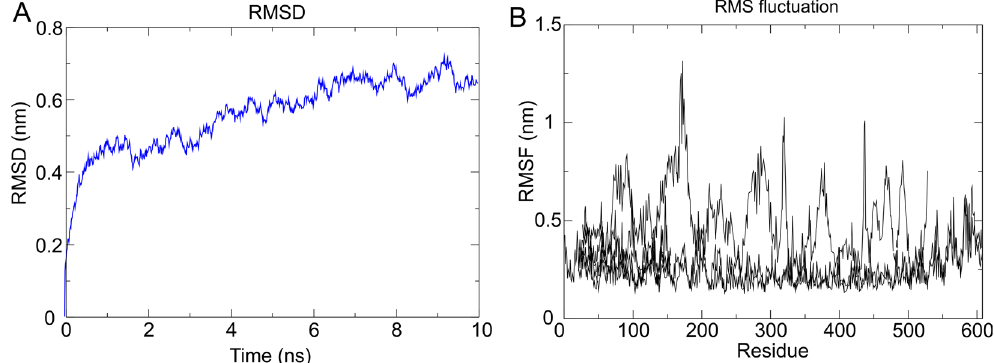
Figure 7. Molecular dynamics simulation study of protein-ligand complex representing. ( A ) Root Mean Square Deviation of the docked complex backbone for the time duration of 10 ns. ( B ) Root Mean Square Fluctuation representation of the docked complex side chains for same time duration.